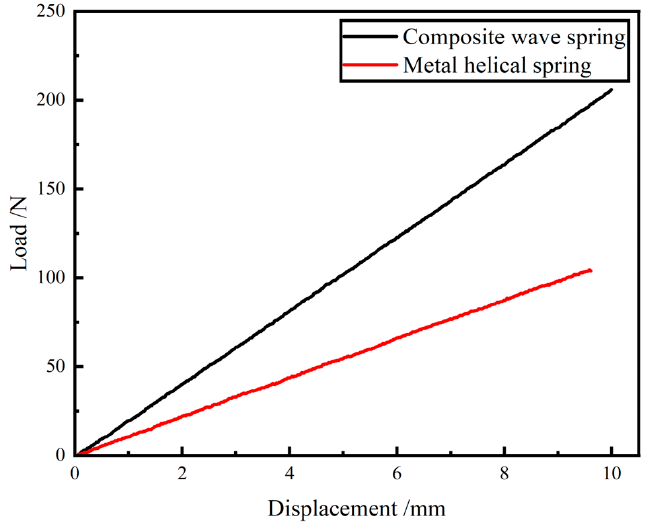
Figure 11. Experiment results of GFRP wave spring and metal helical spring.